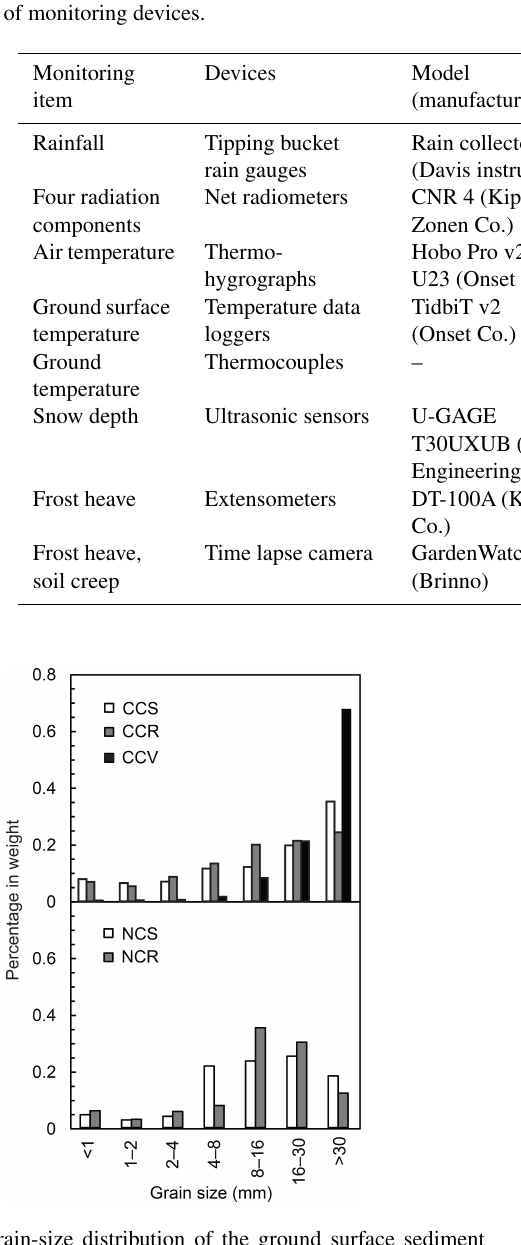
Figure 2. Grain-size distribution of the ground surface sediment around monitoring plots.